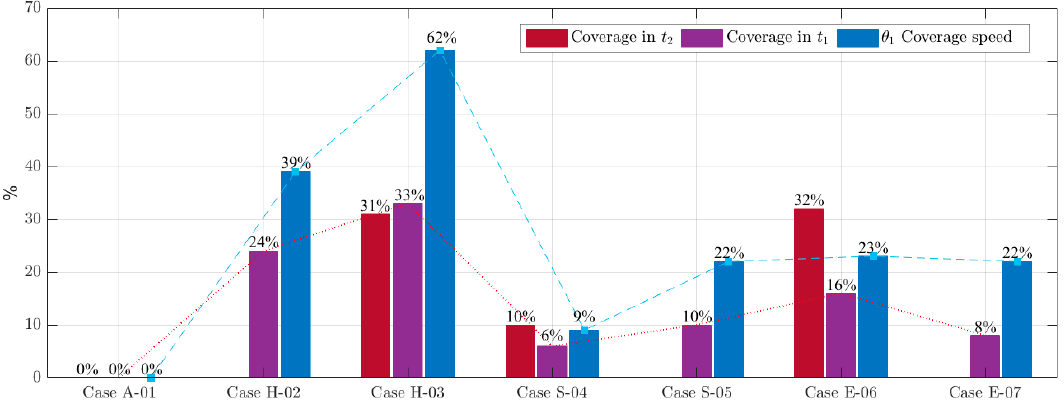
Figure 6. The coverage speed and maximum coverage after 50 min and 150 min through the microchamber for the original experimental setup (case A-01), thin chamber (series H-02), the thin chamber with half-height (case H-03), second outlet with zero pressure (case S-04), suction (case S-05), and electroosmotic flow (cases E-06 and E-07). All values are calculated based on the original case.